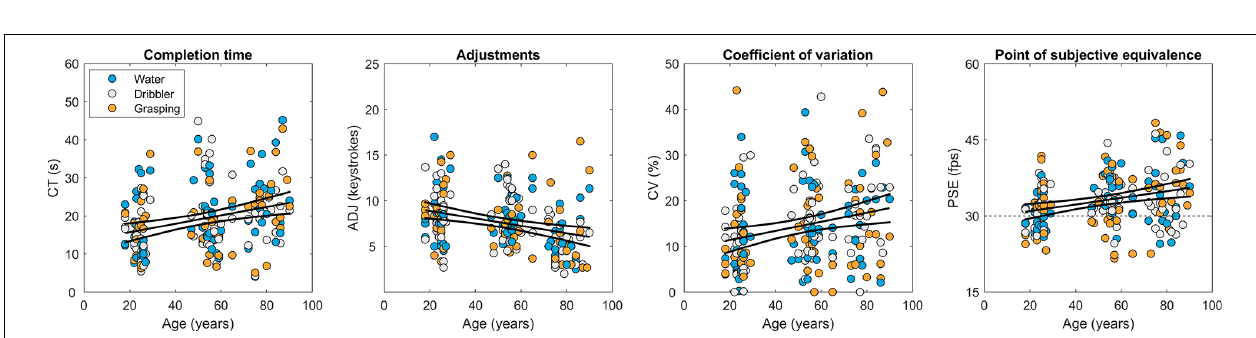
FIGURE 3 | The four indexes of the SoS task (CT, completion time; ADJ, adjustments; CV, coefficient of variation; PSE, Point of subjective equivalence) as a function of age. Each data-point represents the mean value computed over repetitions for each subject and video clip. Colors represent video clips. Also shown are the fitting curves obtained through linear regression (continuous lines), together with the 95% confidence intervals (simultaneous functional bounds). The horizontal dashed line in the PSE plot indicates the original video clip